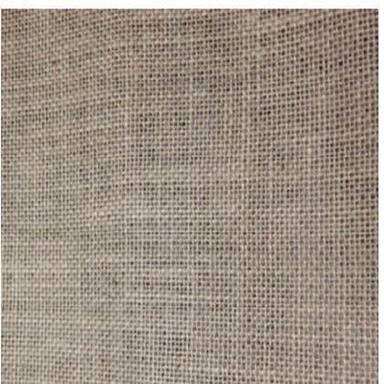
mp Fiber Mat Fig.4 Sugar Tree Fiber Mat